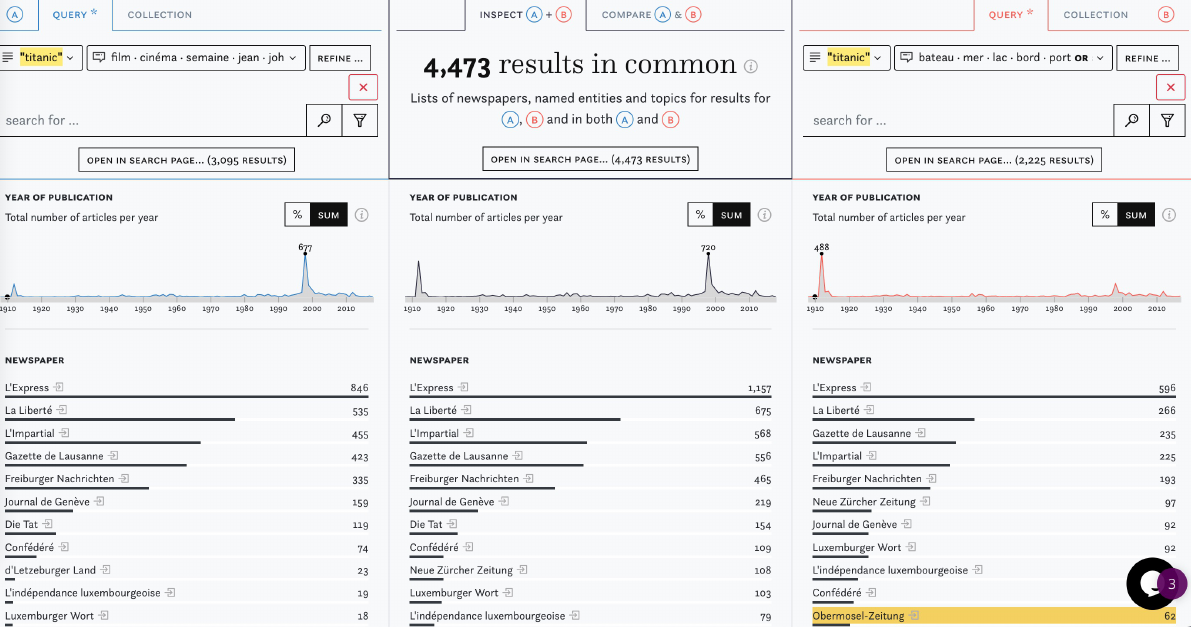
Figure 8. Screenshot from “Inspect” displaying keyword searches for “titanic” filtered by film-related topics ( left ) and by seafaring-related topics ( right